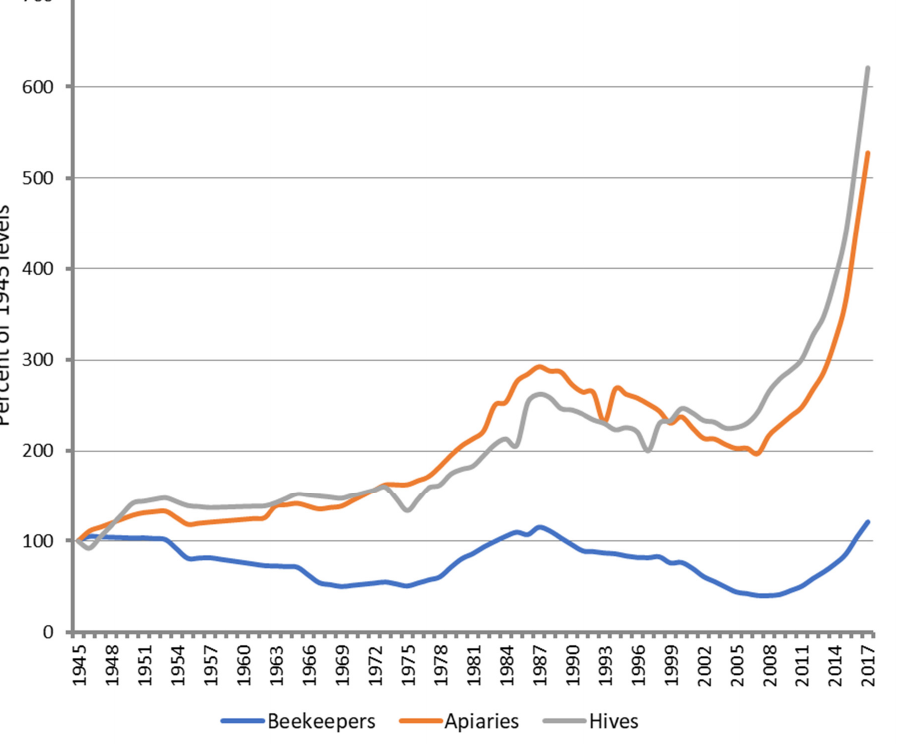
Figure 1. The number of beekeepers, apiaries, and colonies in New Zealand from 1945–2017. Values on the y ‐ axis are expressed as a percentage of the number of colonies reported in the year 1945 (Source, AsureQuality, New Zealand).